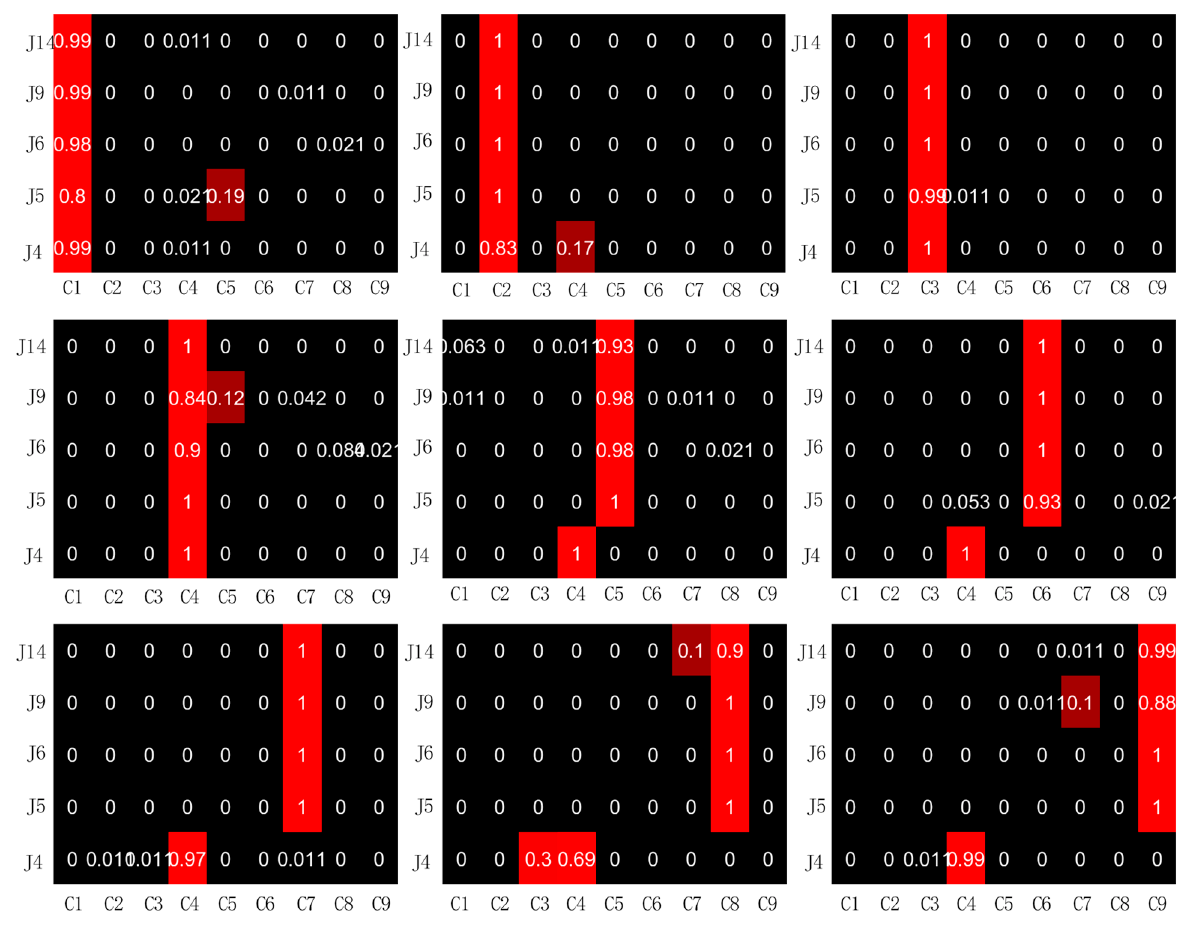
Figure 8. P ij predicted by 5 BICNN models for 9 damage cases.